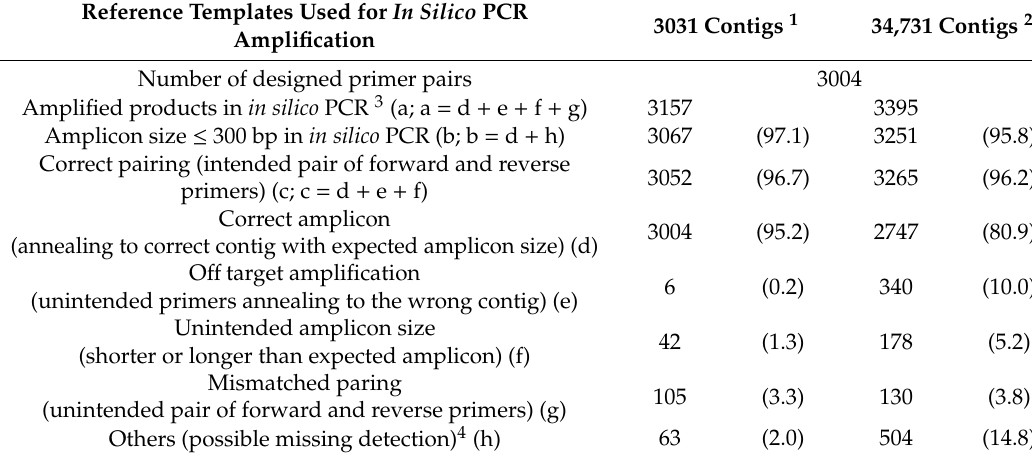
Figure 3. Genotyping summary and comparison between the AmpliSeq custom primer panel and Axiom custom genotyping array: ( a ) number of the SNPs detected with AmpliSeq; ( b ) number of SNPs detected with Axiom; ( c ) number of SNPs in consensus in a comparison between AmpliSeq and Axiom; ( d ) ratio consensus per genotyped SNP by AmpliSeq. Of a total of 16 clones of C. japonica , 16 were genotyped with AmpliSeq and 11 were genotyped with Axiom. Table 1. Summary of in silico PCR evaluations of the custom primer panel for Cryptomeria japonica (L.f.)